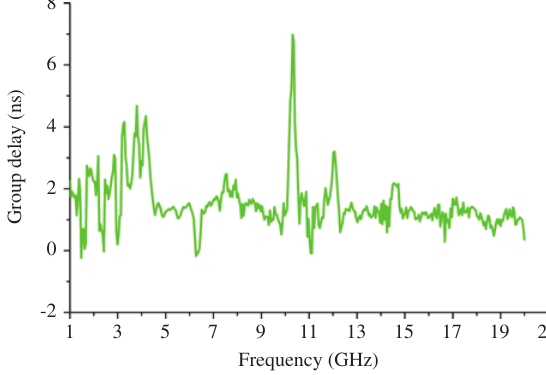
Figure 12: Measured group delay of the proposed